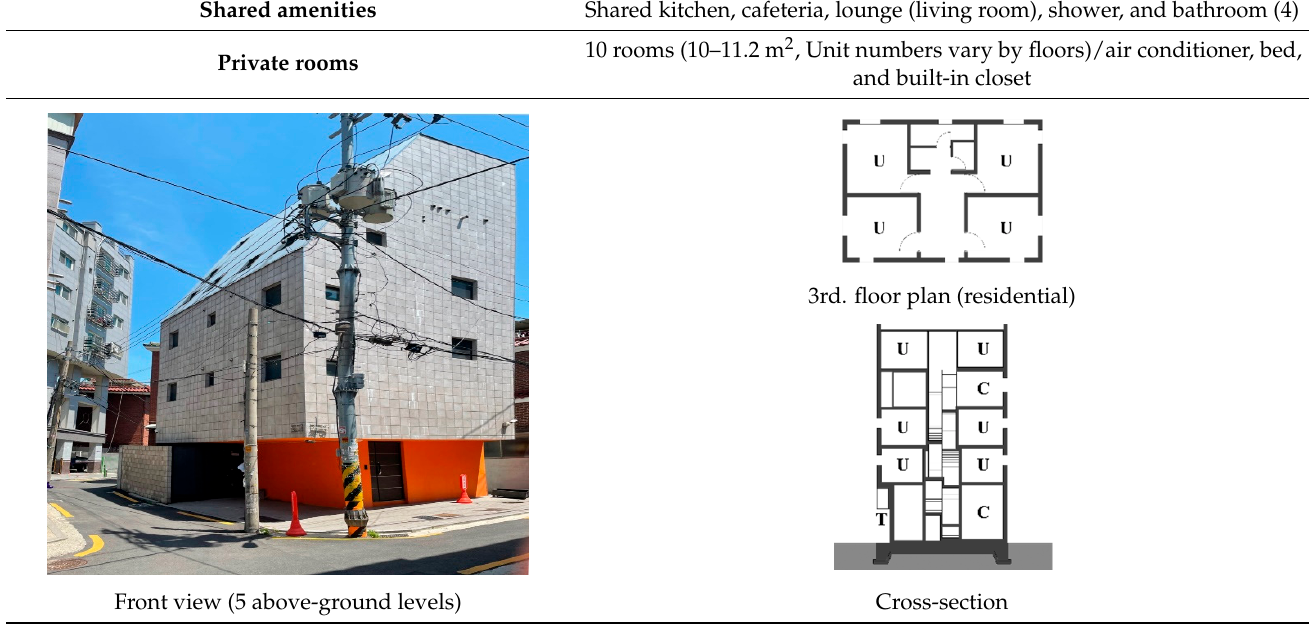
Table 6. Sodam [24,25].